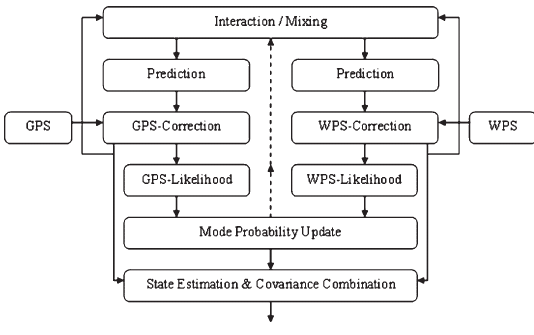
Fig. 4. Block diagram of the IMM algorithm. Fig. 5. Tablet-PC with the u-blox-GPS receiver, the WLAN-Card, and the IMU